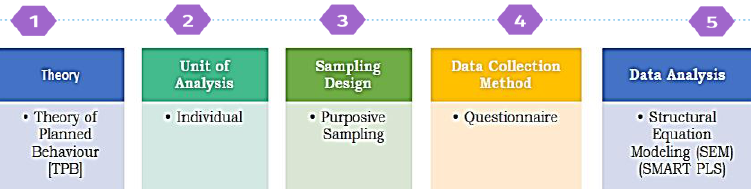
Figure 2. Research design.